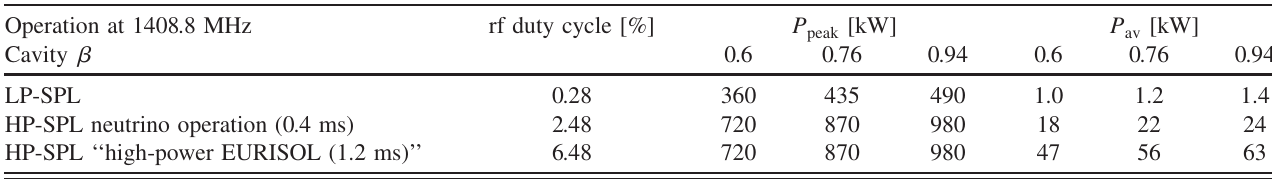
TABLE XIX. Maximum rf power per cavity when operating at 1408.8 MHz. Operation at 1408.8